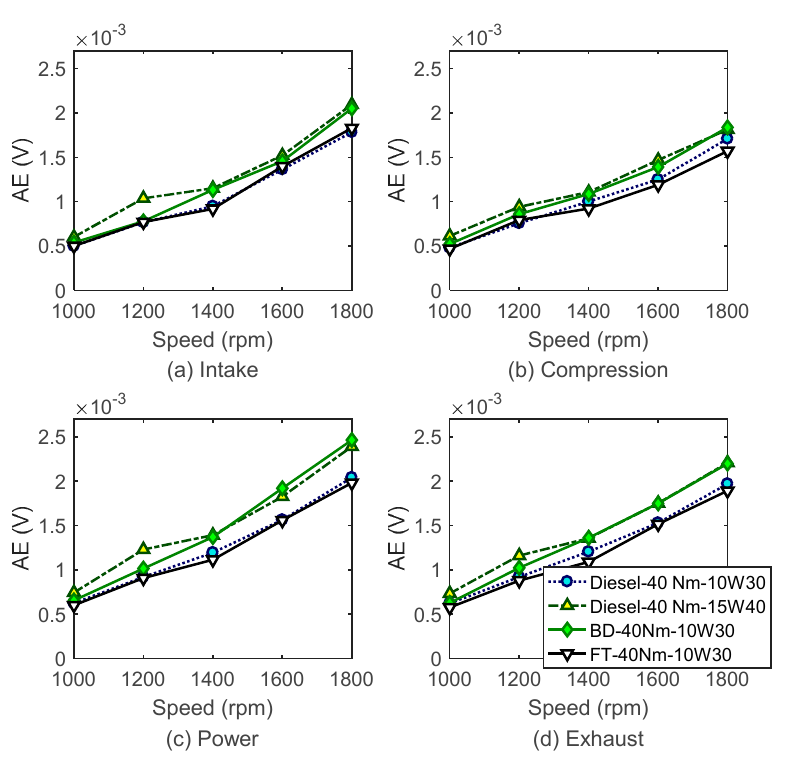
Figure 12. FAS–AE indicators of different fuels under low load: ( a ) Intake; ( b ) Compression; ( c ) Power; ( d ) Exhaust.